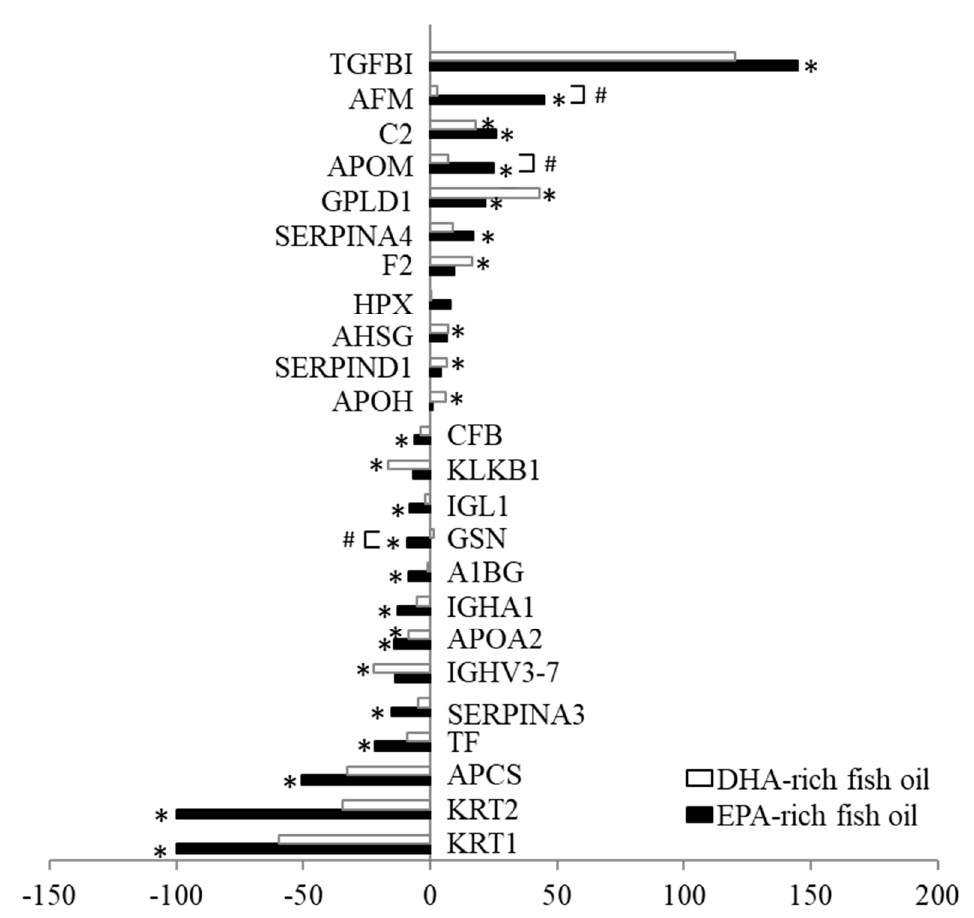
Figure 5. Changes (%) compared with baseline values in altered HDL-related lipoprotein proteome after an 8-week dietary supplementation with EPA-rich or DHA-rich fish oils (n = 10). TGFBI: Transforming growth factor-beta-induced protein ig-h3; AFM: Afamin; C2: Complement C2; APOM: Apolipoprotein M; GPLD1: Phosphatidylinositol-glycan-specific phospholipase D; SERPINA4: Kallistatin; F2: Prothrombin; HPX: Hemopexin; AHSG: Alpha-2-HS-glycoprotein; SERPIND1: Heparin cofactor 2; APOH: Beta-2-glycoprotein 1; CFB: Complement factor B; KLKB1: Plasma kallikrein; IGL1: Immunoglobulin lambda-1 light chain; GSN: Gelsolin; A1BG: Alpha-1B-glycoprotein; IGHA1: Immunoglobulin heavy constant alpha 1; APOA2: Apolipoprotein A-II; IGHV3-7: Immunoglobulin heavy variable 3–7; SERPINA3: Alpha-1-antitrypsin; TF: Serotransferrin; APCS: Serum amyloid P-component; KRT2: Keratin, type II cytoskeletal 2 epidermal; KRT1: Keratin, type II cytoskeletal 1. * p < 0.05 compared with baseline; # p < 0.05 between EPA-rich and DHA-rich fish oil supplements.